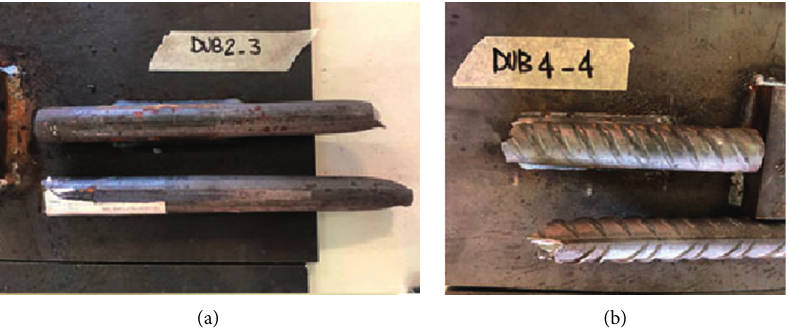
Figure 9: Failure in correspondence of large-diameter Dub joints. The difference between smooth and ribbed bar is evident: in structural steel necking is visible, highlighting the ductile behaviour, while in case of TempCore ® the fracture happened in the HAZ.